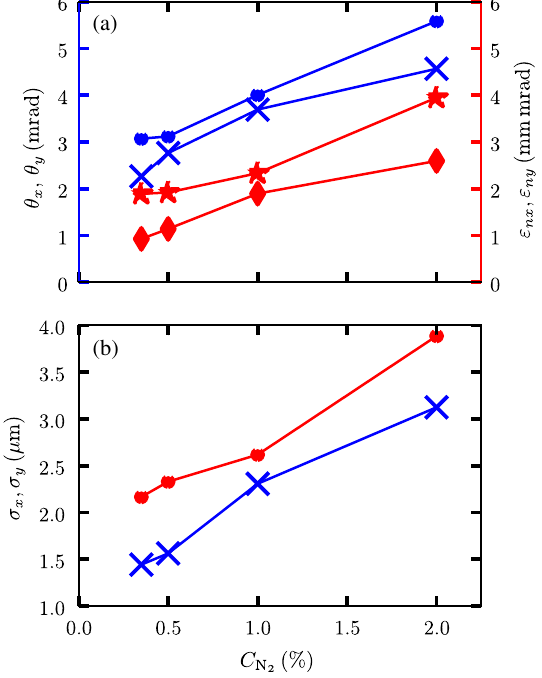
FIG. 9. Accelerated beam divergence and emittance with respect to C , evaluated at the exit of the plasma target. N 2 (a) On the left axis: rms divergence θ x in x -direction (blue crosses), and θ y in y -direction (blue dots) with respect to C the right axis: normalized rms emittance ε nx in x -direction (red diamonds), and ε ny in y -direction (red stars) with respect to C (b) Apparent electron bunch length σ x in x -direction (blue crosses), and σ y in y -direction (red dots) with respect to C